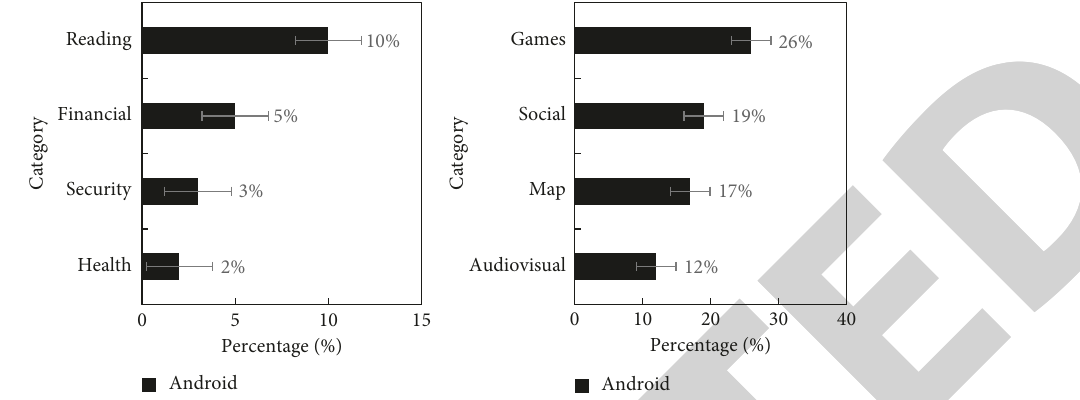
Figure 7: Application download details on the Android platform.